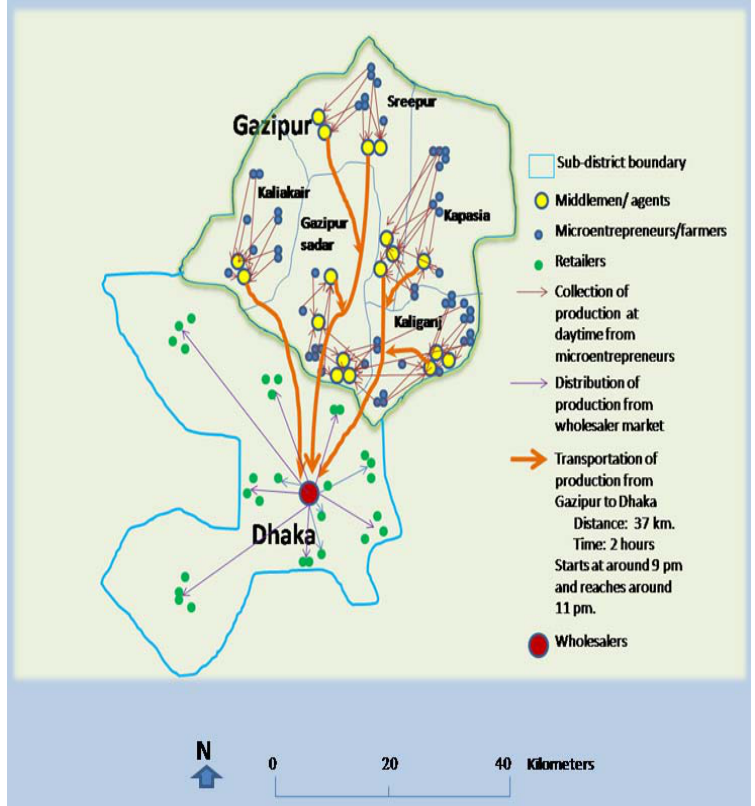
Figure 3. Origin and destination of poultry value